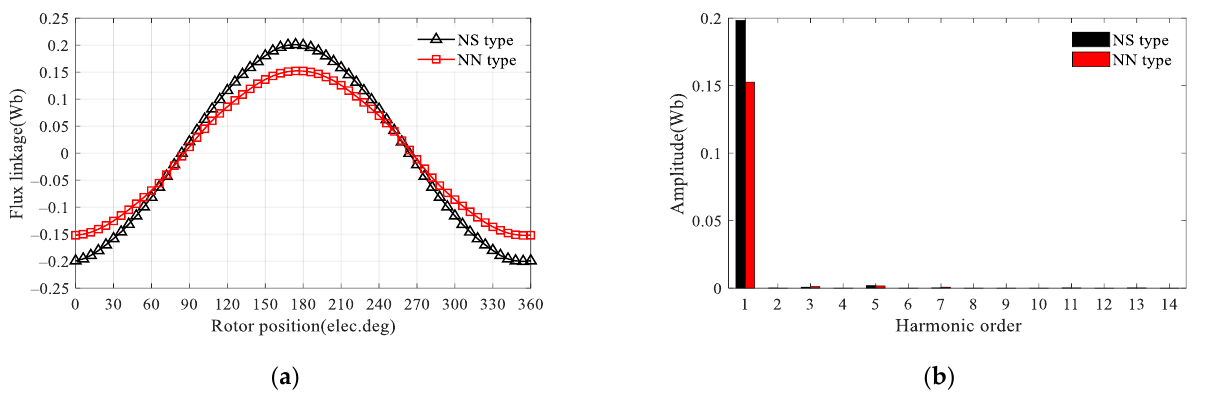
Figure 13. Comparison of no-load phase flux linkage waveforms at rated speeds. ( a ) Waveform; ( b ) harmonic spectra.